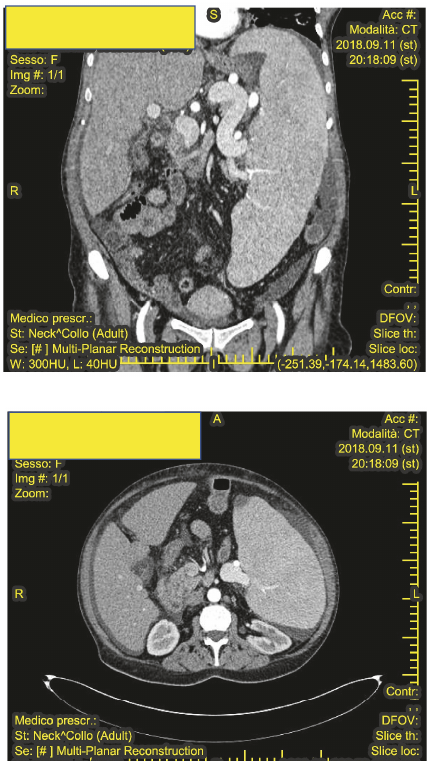
Figure 1: Thoracic -abdominal CT with contrast medium which confirmed the presence of adenopathy in the mediastinal space.